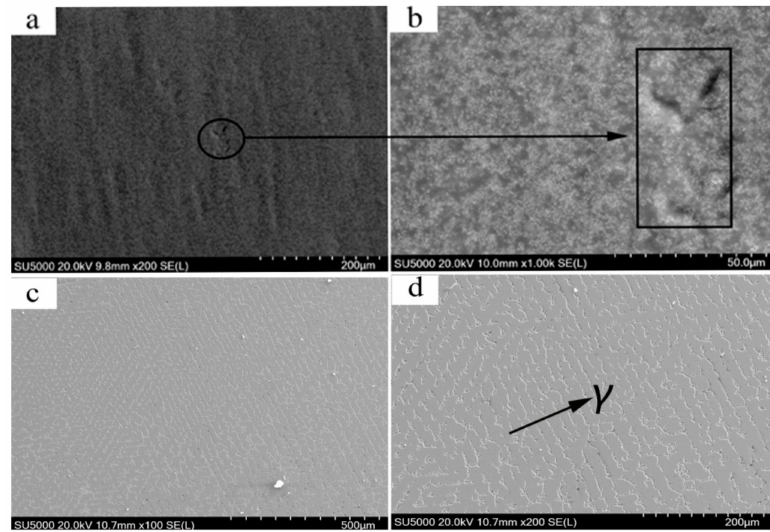
Figure 3. Scanning election microscopy (SEM) micrograph of pure CoCr alloy powder molding. ( a ) Surface morphology of the sample; ( b ) the surface of the sample is magnified 1000 times; ( c ) sample grain results; ( d ) sample grain structure magnified 1000 times.